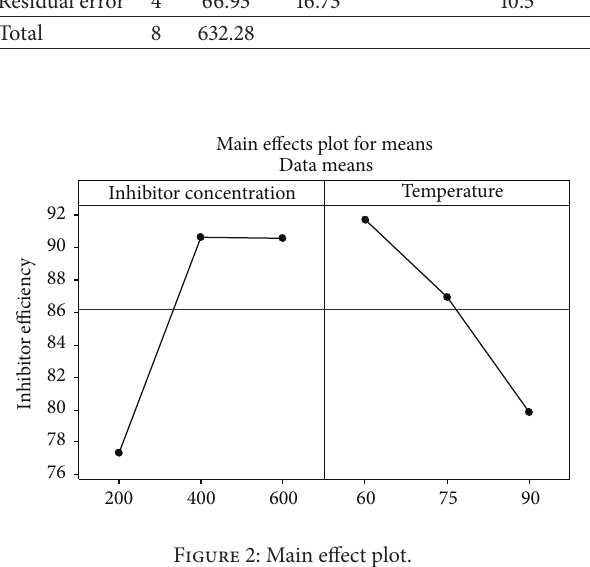
Figure 2: Main effect